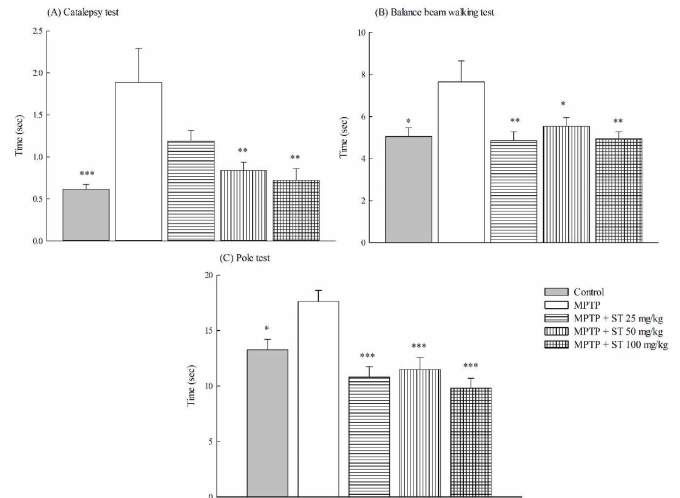
Figure 3. Effect of Sophora tomentosa extract (25 mg/kg, 50 mg/kg, and 100 mg/kg, po) on ( A ) the catalepsy test, ( B ) the balance beam walking test, and ( C ) the pole test in an MPTP-induced Parkinson disease (PD) mouse model. Data are expressed as mean ± SEM ( n = 10). * p < 0.05, ** p < 0.01, *** p < 0.001, compared with the MPTP group. Sophora tomentosa was administered for 15 consecutive days until the behavioral tests. MPTP (20 mg/kg, ip) were given two times at four-hour intervals daily for five days until behavioral tests. MPTP: 1-methyl-4-phenyl-1,2,3,6-tetrahydropyridine, PD: Parkinson’s disease, ST: Sophora tomentosa .